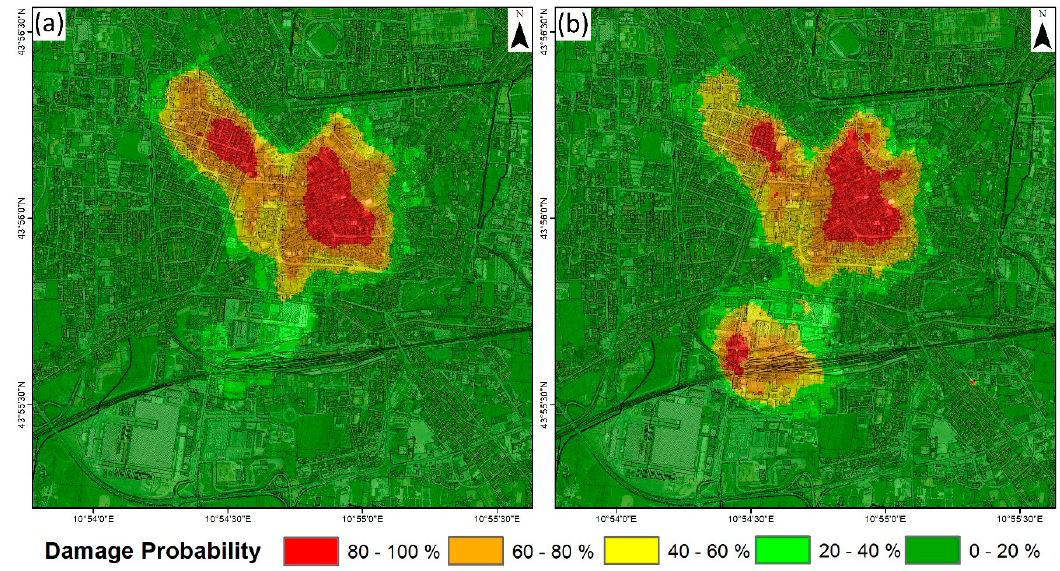
Figure 7. Mean vertical velocities of the inspected buildings in S-1 ( a ) and CSK ( b ), and fragility curves of the damaged buildings for them.